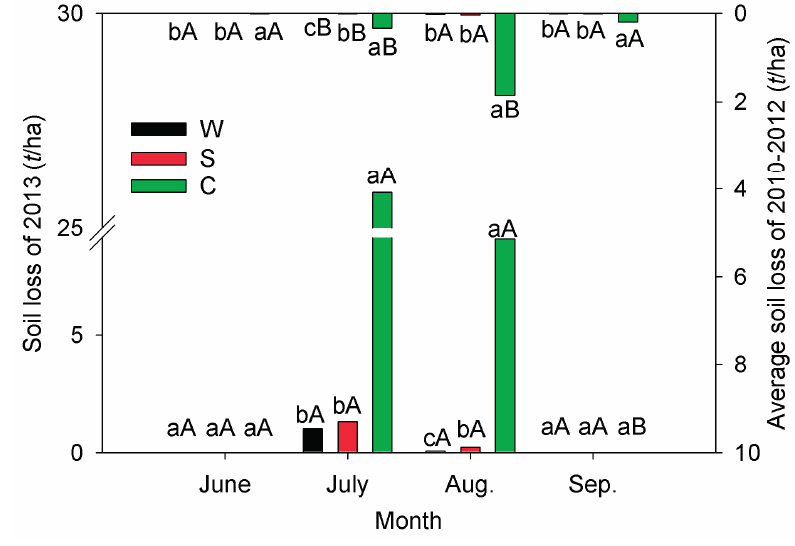
Figure 7. Monthly soil losses in the “extreme year” and “normal year”. The capital and lower-case letters represent the significance of the difference ( p < 0.05) as those in Figure